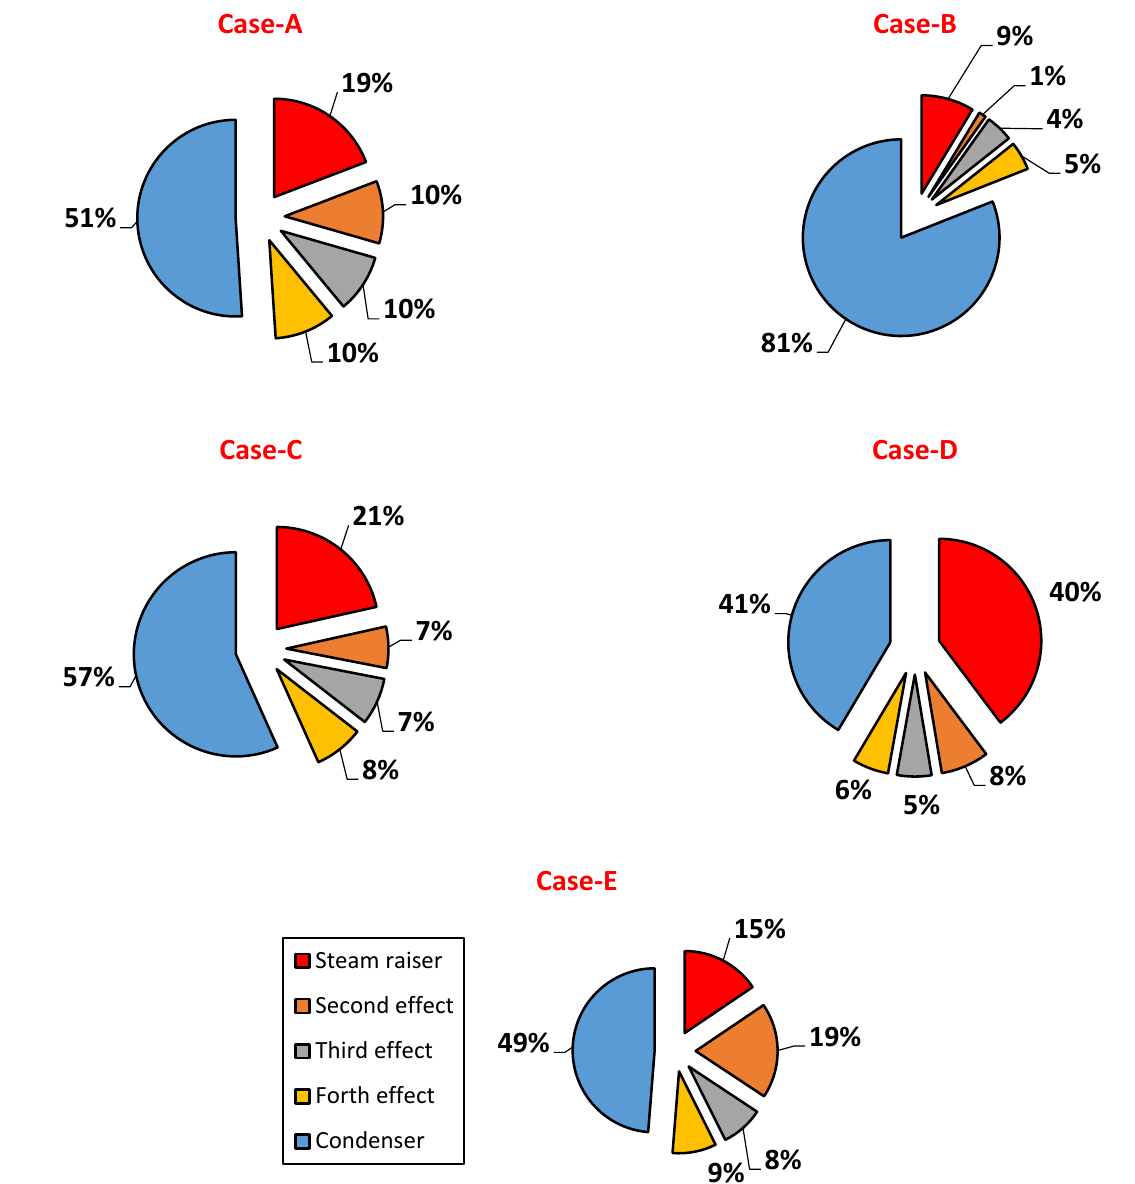
Figure 14. Exergy destruction for the various components of the V-MEMD system under the input conditions specified in Table 5. ( Case-A ): reference case; ( Case-B ): 𝑇 ℎ,𝑖𝑛 = 55 𝑜 𝐶 ; ( Case-C ): 𝑉̇ 𝑓 = 159 𝐿/ℎ ; ( Case-D ): 𝑇 𝑓,𝑖𝑛 = 25 𝑜 𝐶 ; ( Case-E ): 𝑤 = 45,900 𝑝𝑝𝑚